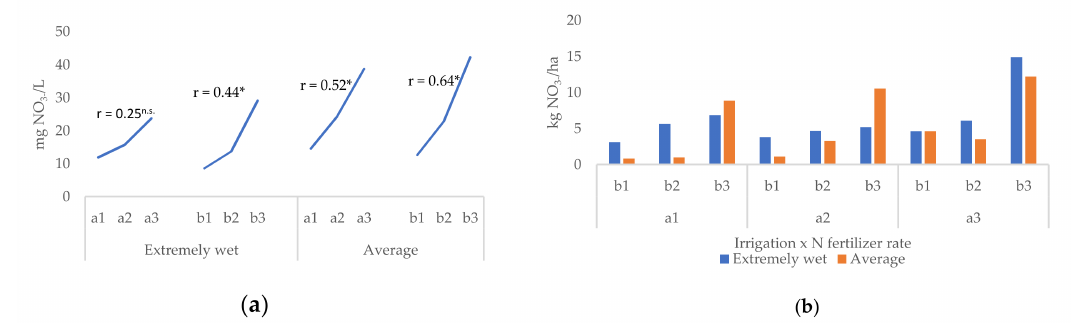
Figure 12. Leaching losses across sampling times for ( a ) irrigation levels (a1 = rainfed, a2 = 60–100% FC, and a3 = 80–100% FC) and N fertilizer rates (b1 = 0 kg N ha − 1 , b2 = 100 kg N ha − 1 , and b3 = 200 kg N ha − 1 ) significantly different at p < 0.05 (*), and ( b ) leaching losses (kg NO 3 − ha − 1 ) in the extremely wet and average